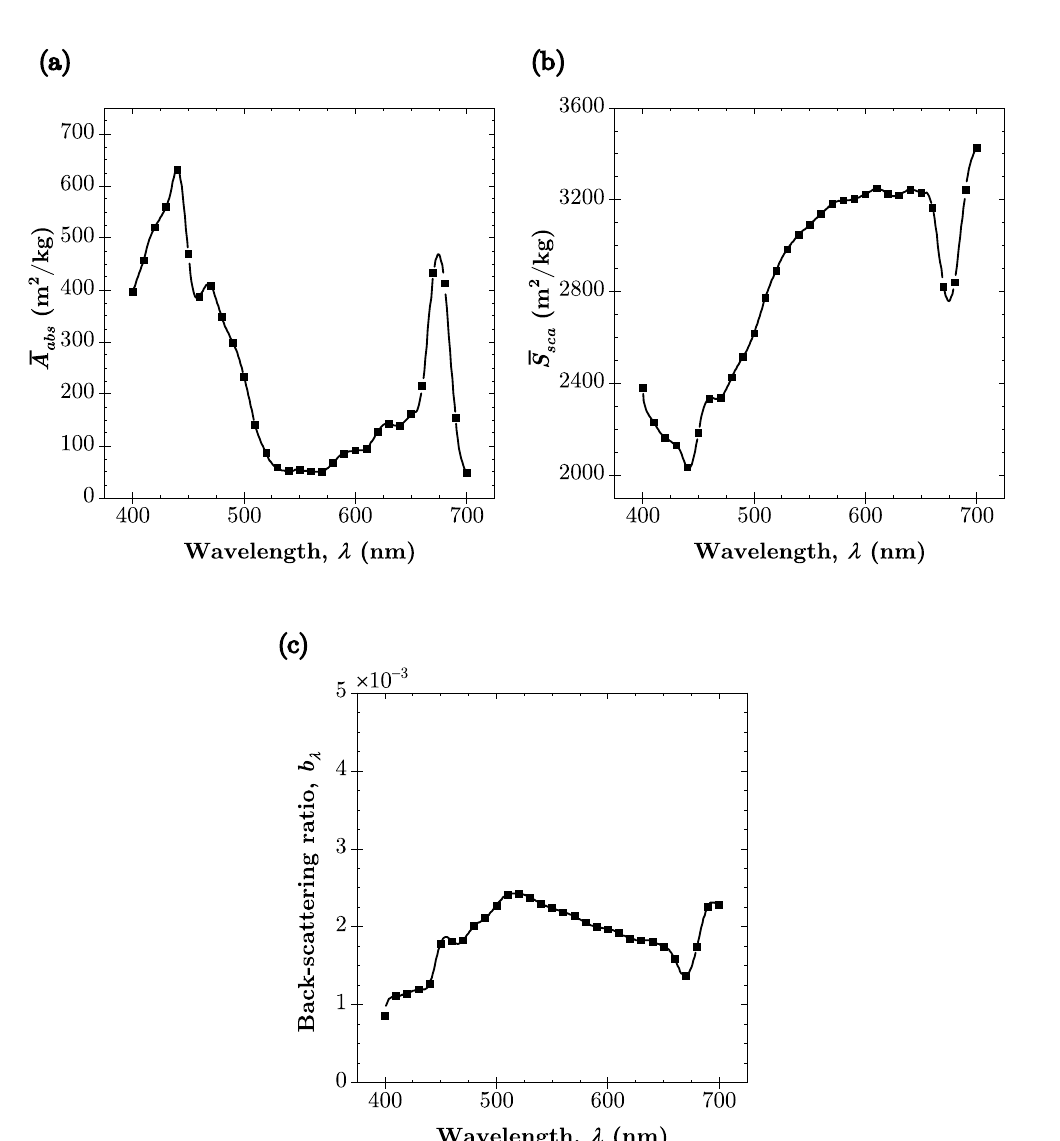
Figure A1. Average spectral mass ( a ) absorption ¯ A abs , λ and ( b ) scattering ¯ S sca , λ cross-sections taken from [9] for Chlorella vul- garis with a mean cell radius of 2 µ m and chlorophyll a , chlorophyll b , and photoprotective carotenoid (PPC) concentrations of 3.3 wt.%, 0.85 wt.%, and 0.85 wt.%, respectively. ( c ) Spectral backward scattering ratio b λ as a function of wavelength λ calculated using the method presented in